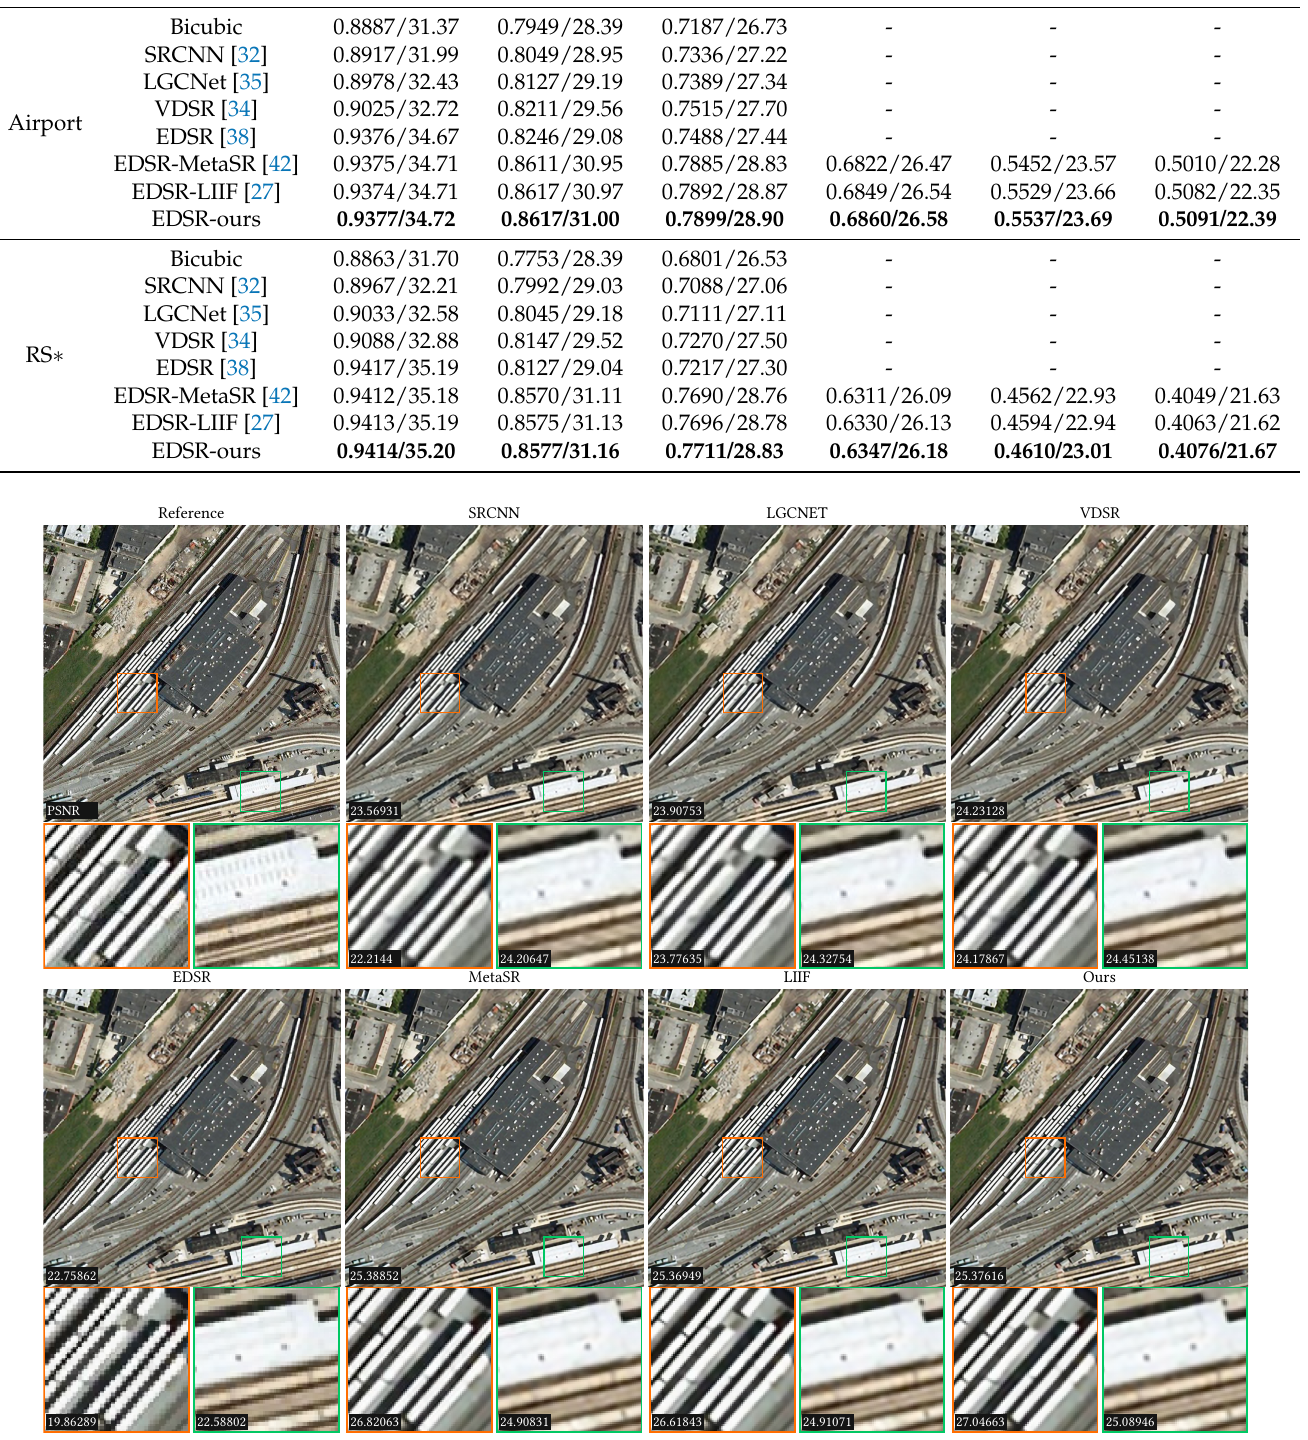
Figure 4. Comparison results of the × 3 scale on the railwaystation_190 scene of the AID dataset. Two local regions are zoomed in to show the detailed results. The PSNR values are listed in the bottom-left